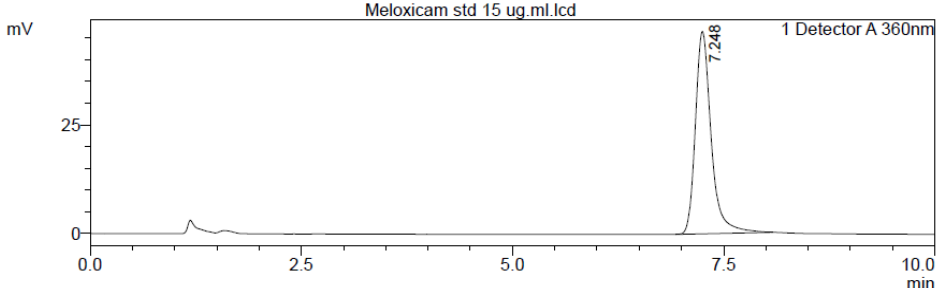
Figure 8. Chromatogram for a plasma spiked with 15 g · mL − 1 of standard meloxicam. Table 3. Intraday and Interday assay coefficient of variance (% CV) in assay of meloxicam using HPLC.